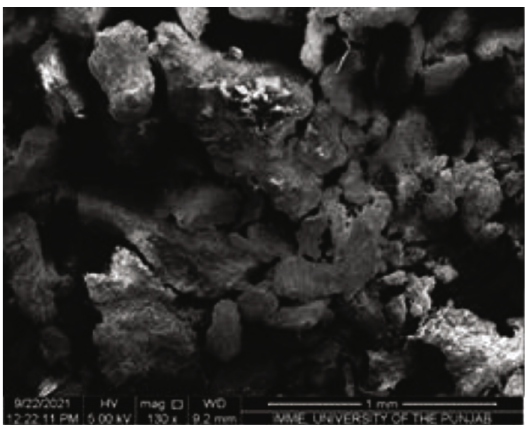
Figure 4: SEM image of